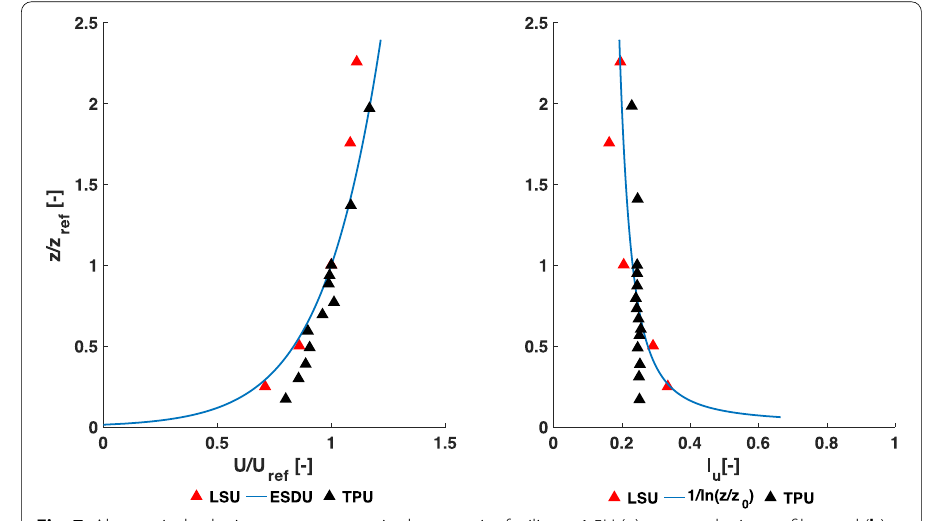
Fig. 7 Along-wind velocity measurements in the open-jet facility at 1.5H ( a ) mean-velocity profiles, and ( b ) turbulence intensity profiles